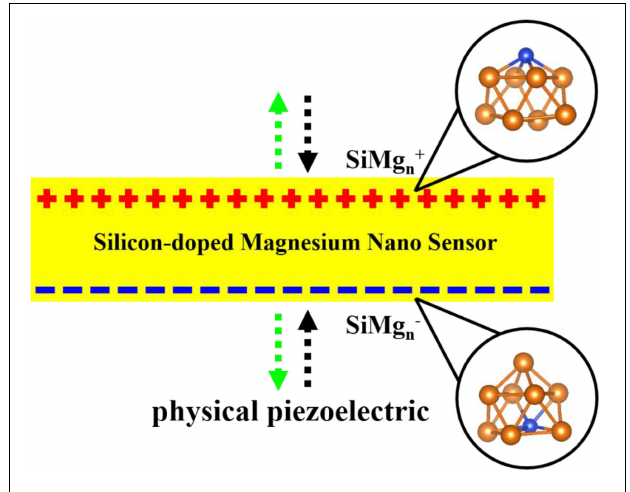
FIGURE 1 | Silicon-doped magnesium nano-ceramic cluster under physical piezoelectric